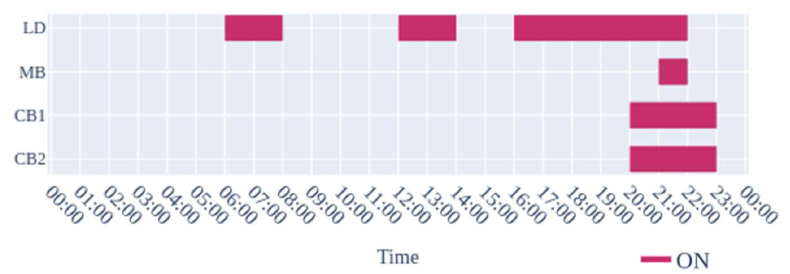
Figure 8. Heating load usage plan (cold seasons) .